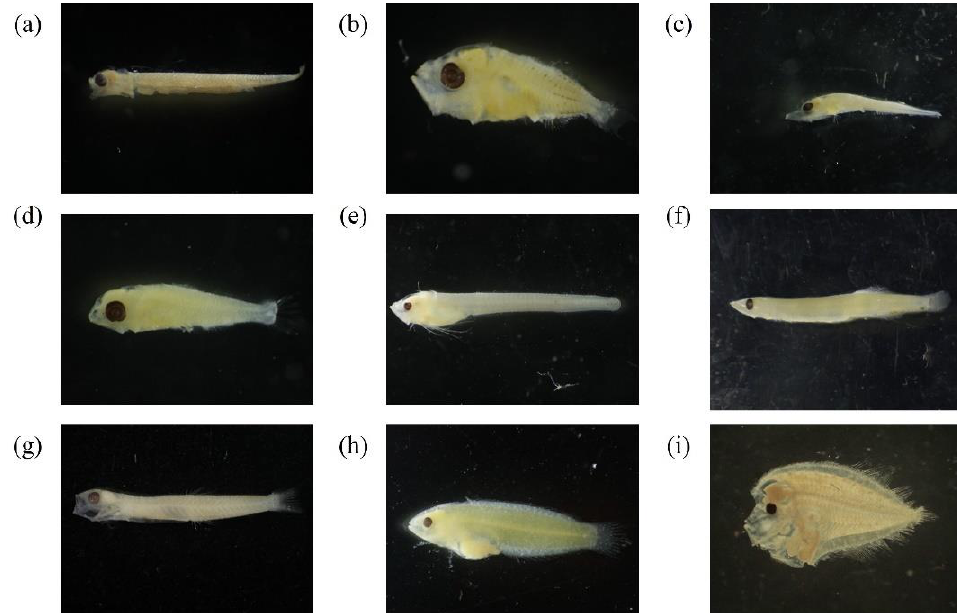
Figure 2. Photographs of the top three catches of fish species (larvae and juveniles) from three different depth zones (pelagic, mesopelagic, and demersal) in this study (around Taiwan from 2007 to 2019): ( a ) Engraulis japonicus (top catch in the pelagic zone) ; ( b ) Decapterus spp. (2nd highest catch in the pelagic zone); ( c ) Trichiurus spp. (3rd highest catch in the pelagic zone); ( d ) Diaphus B group (top catch in the mesopelagic zone); ( e ) Bregmaceros spp. (2nd highest catch in the mesopelagic zone); ( f ) Vinciguerria nimbaria (3rd highest catch in the mesopelagic zone); ( g ) Gobiidae spp. (top catch in the demersal zone); ( h ) Labridae spp. (2nd highest catch in the demersal zone); and ( i ) Bothidae spp. (3rd highest catch in the demersal zone).